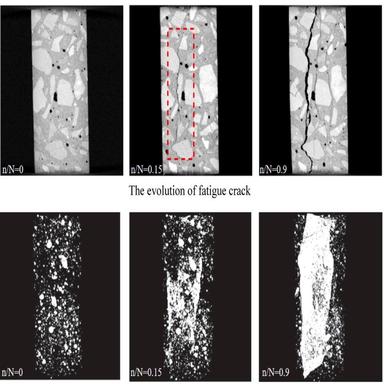
The ICT images for (a) the fatigue damage evolution in concrete specimens with the size of 50 mm in diameter and 100 mm in height under compressive fatigue loading and (b) the distribution of detected pores under the stress level of 80 % adapted from .